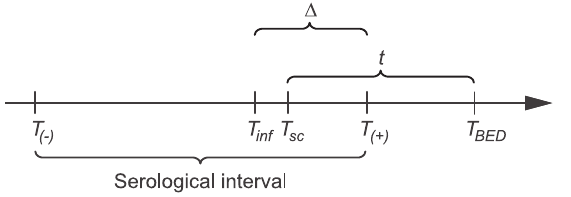
Figure 1. Definitions of dates and time intervals relative to BED testing. The time since seroconversion ( t ) is the time from the date a patient seroconverted ( T sc ) to when a sample for BED testing was collected ( T BED ). We estimate t by a logistic IgG model (Eq. 1) as ‘ t . Date of infection ( T inf ) occurred on average 21 days prior to T sc [9,10]. When available, the patient history also includes the dates of last negative HIV-1 antibody testing ( T ( 2 ) ) and first positive HIV-1 antibody testing ( T ( + ) ), defining the serological interval. Note that T ( + ) and T BED may often occur at the same date. To reevaluate national Swedish HIV surveillance data we compared ‘ T inf with T ( + ) , resulting in a time difference D .